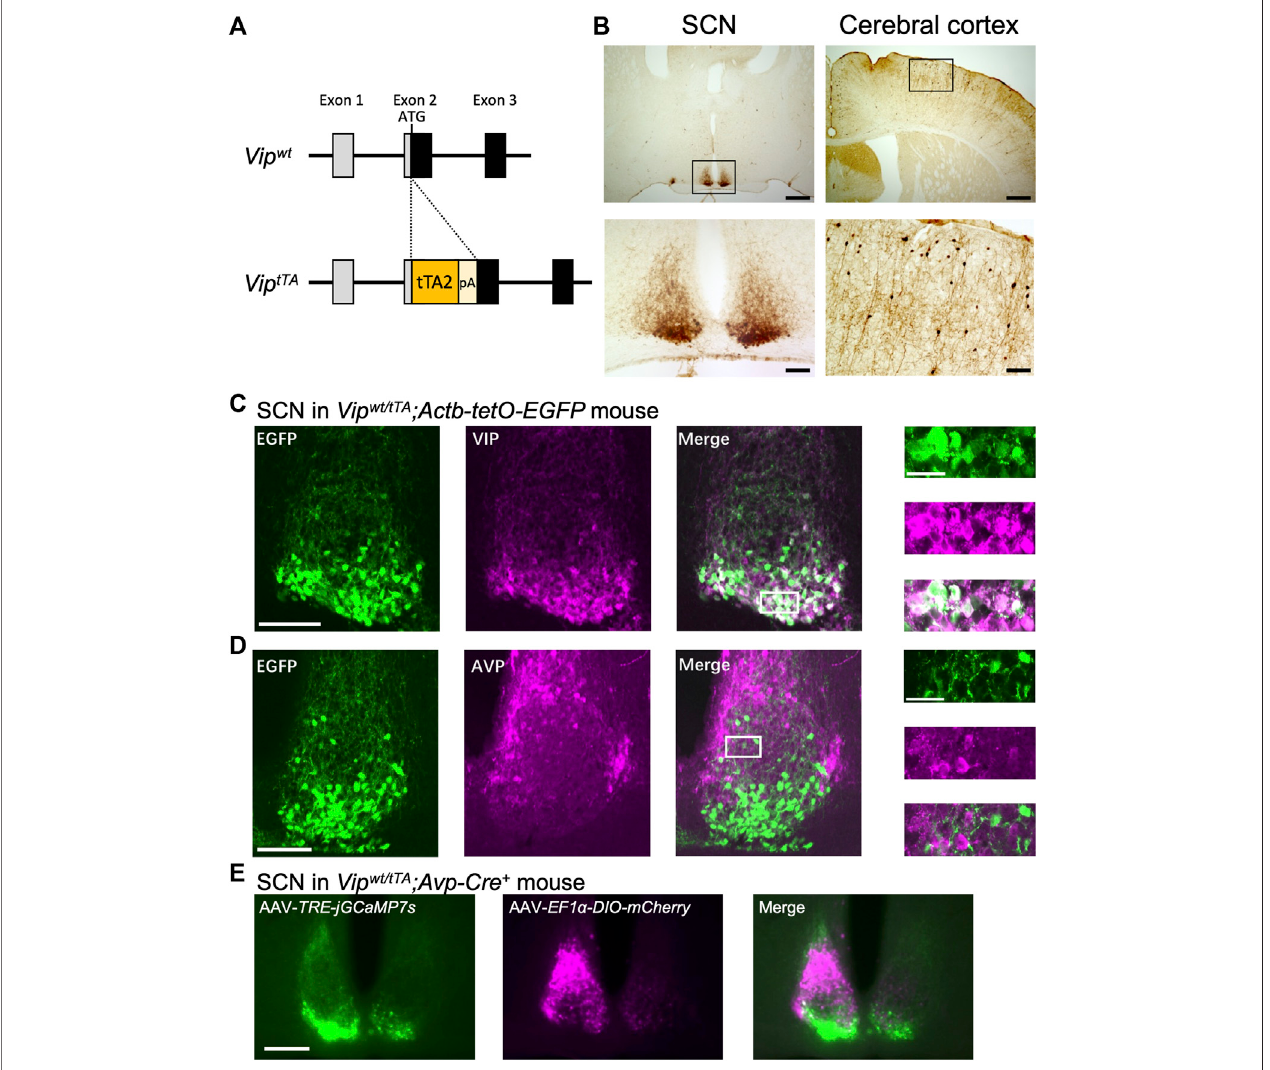
FIGURE 1 | Generation and validation of Vip tTA knock-in mice. (A) Targeting strategy for generating Vip tTA mice. A tTA2-polyA cassette was inserted at the start codon of Vip gene in exon 2. (B) tTA-mediated EGFP expression was mostly restricted in the SCN and cerebral cortex in Vip wt/tTA mice crossed with Actb-tetO-EGFP reporter mice. Coronal brain sections were immunostained for GFP in brown. Lower panels (scale bar, 100 μ m) are magni fi ed images of regions indicated by rectangles in upper panels (scale bar, 500 μ m). (C – D) Coronal brain sections prepared from Vip wt/tTA ;Actb-tetO-EGFP mice were immunostained for VIP (C) or AVP (D) in magenta(middle).NativeEGFP fl uorescentimagesareshownonleft.Thewhiterectanglesinthemergedimages(scalebar,100 μ m)indicatetheregionsoftheenlarged images (far right; scale bar, 30 μ m). For fl uorescent immunostaining, mice were pretreated with intracerebroventricular injections of colchicine (40 μ g in 1 μ l saline) for 48 h before transcardial perfusion of 4% paraformaldehyde fi xative. (E) Differential labeling of VIP and AVP neurons in the SCN of Vip wt/tTA ;Avp-Cre + mice. AAV -EF1 α - DIO-mCherry and AAV -TRE-jGCaMP7s were injected unilaterally into the SCN in Vip wt/tTA ;Avp-Cre + mice. A representative coronal section of the SCN is shown (scale bar,200 μ m)(n=3).NotethatjGCaMP7s-labeledneurons(left,green)areintheSCNcore,whilemCherry-labeledneurons(middle,magenta)areintheSCNshell.These two populations of neurons rarely overlap